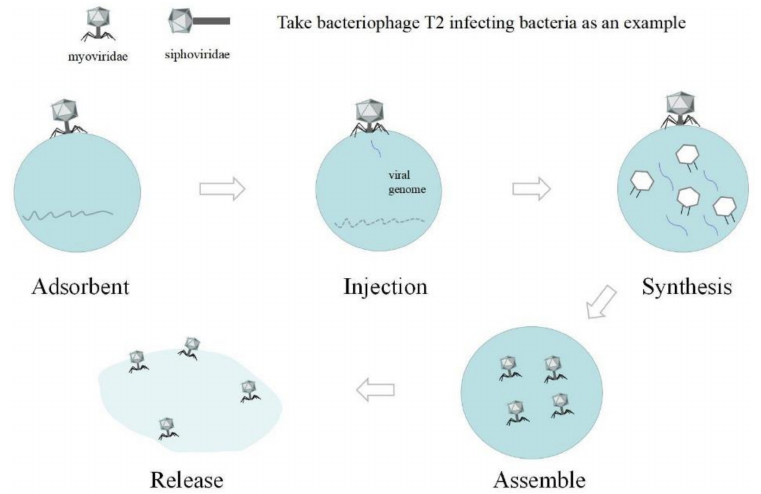
Figure 2. Phage infection